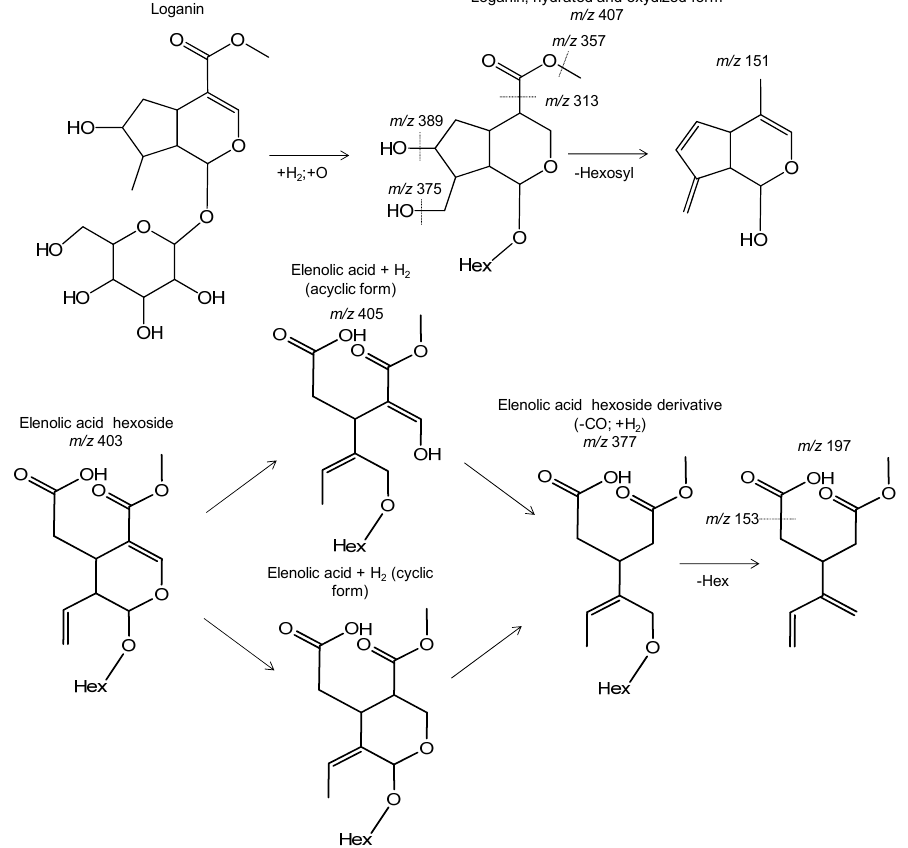
Figure 5. Tentative structure of novel free secoiridoids characterized by mass spectrometry in olive byproducts.